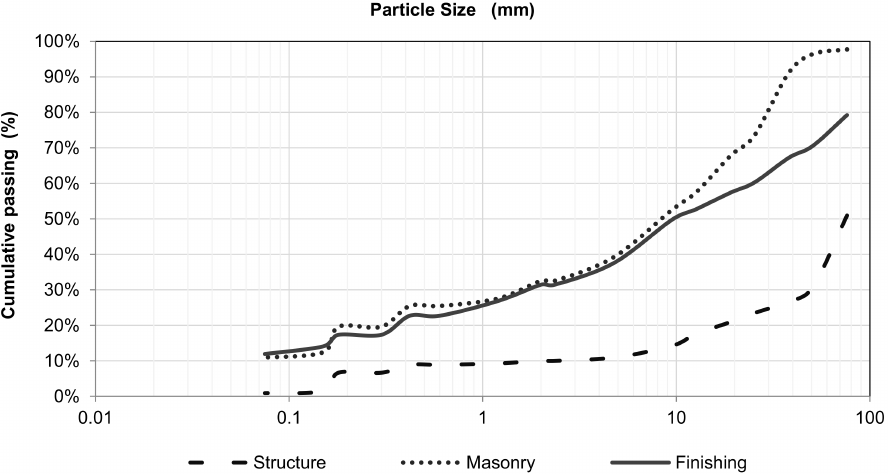
Figure 4. Particle size distribution curves of the waste collected in the construction sites. Table 2. Results of the characterization program of the waste collected in the construction sites. Parameter 1